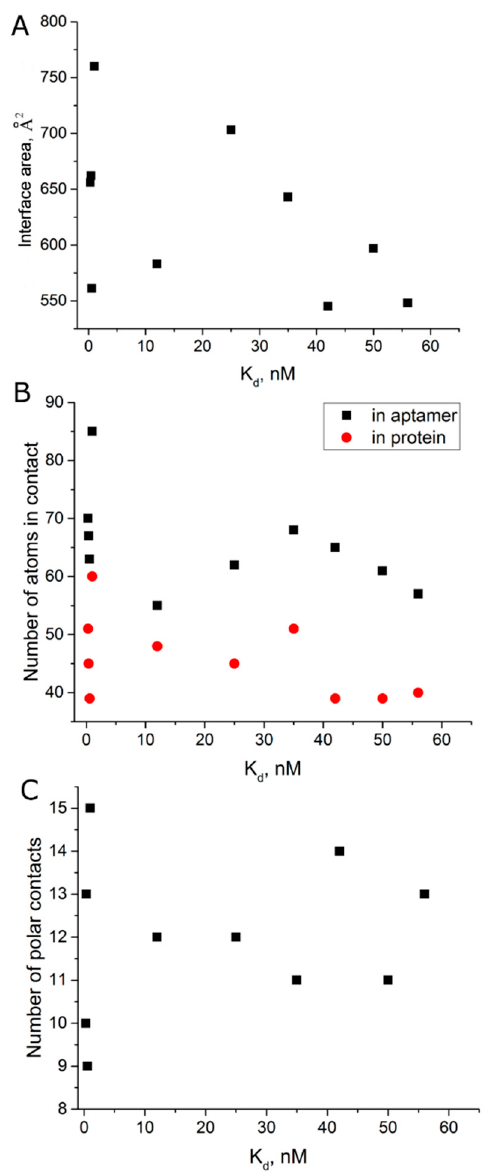
Figure 5. Analysis of gross structural parameters of aptamer–thrombin complexes revealed no correlation with dissociation constants. ( A ) interface area, ( B ) number of contacting atoms in contact in aptamer (black) and in protein (red), ( C ) number of polar contacts.